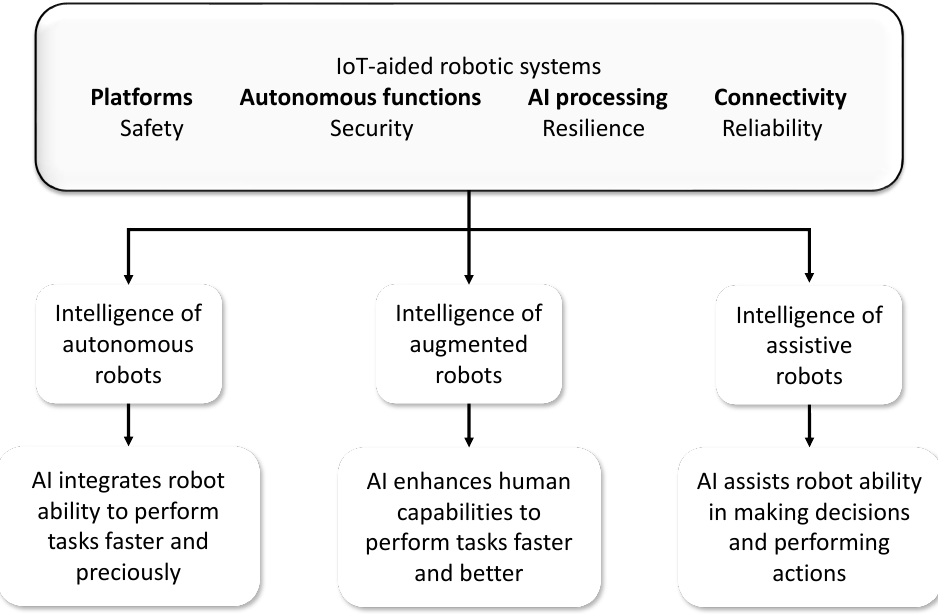
Figure 6. Capabilities implemented at the edge of IoT-aided robotic